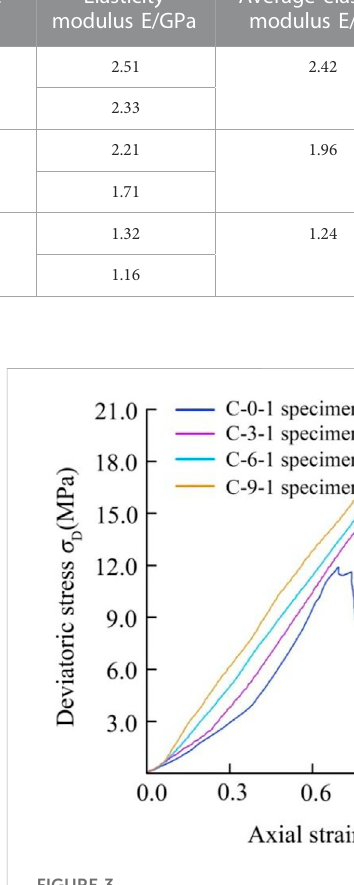
FIGURE 3 Deviatoricstress- axial strain ( σ D - ε 1 )curvesofcoal specimenunder different con fi ning